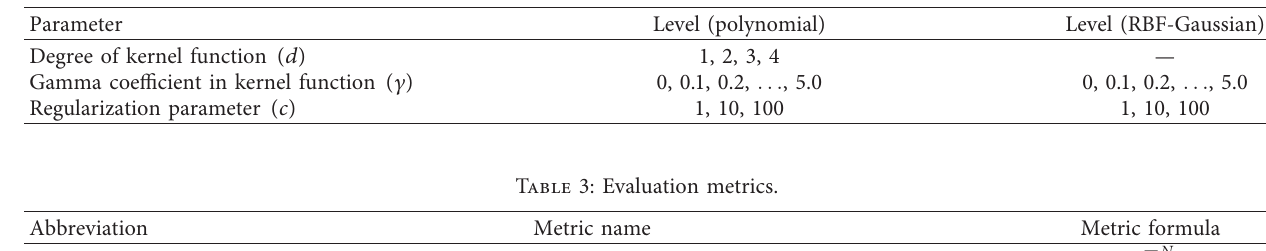
Table 2: Parameter settings for SVR.